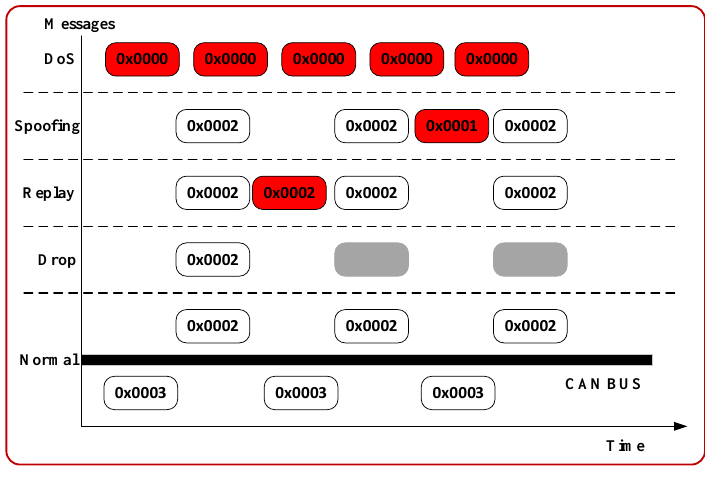
Figure 1. Diagram of malicious attacks in an in-vehicle CAN